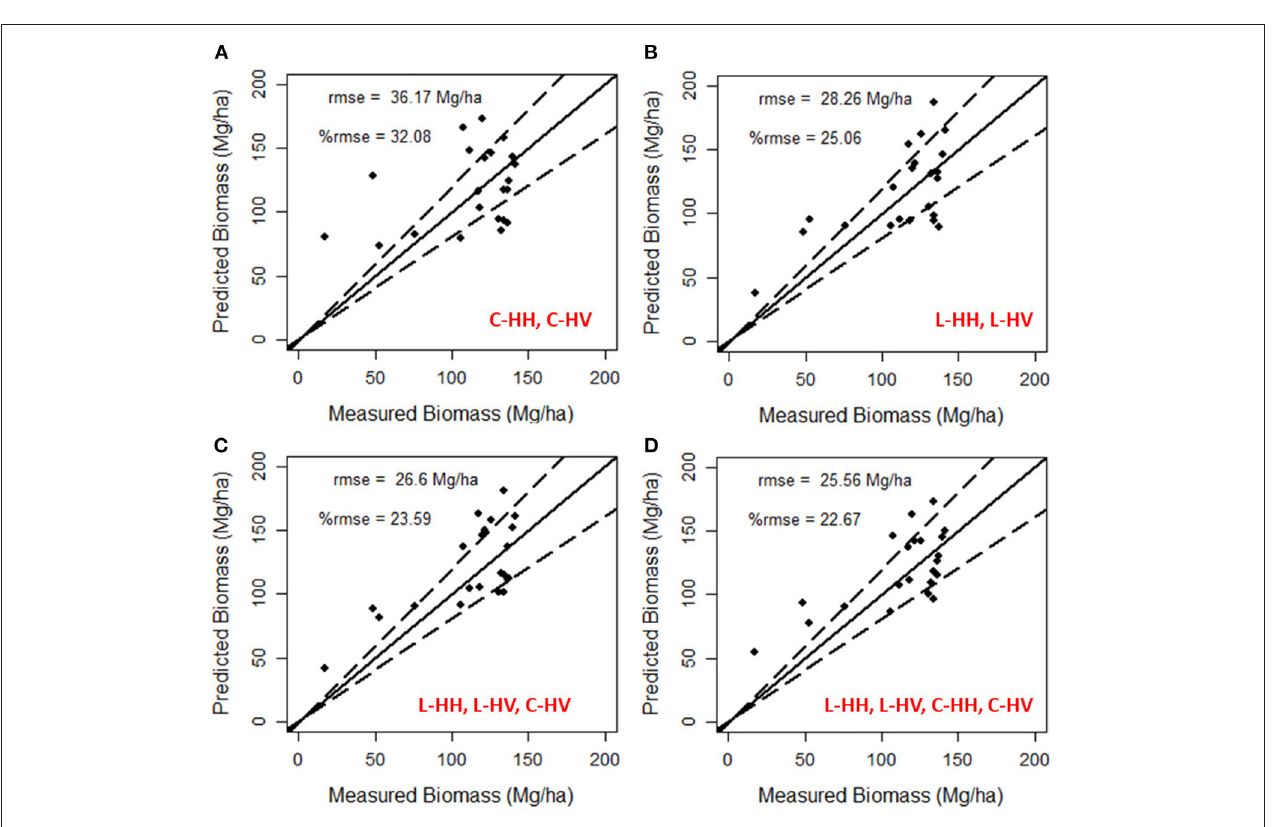
FIGURE 6 | Validation of modeled forest above-ground biomass derived from Random Forest regression models on (A) L-band backscatter, (B) C-band backscatter, (C) combination of L- γ 0 HH , L- γ 0 HV , and C- γ 0 HV , and (D) combination of L-band and C-band backscatter. Dotted lines show the 20% error limit.